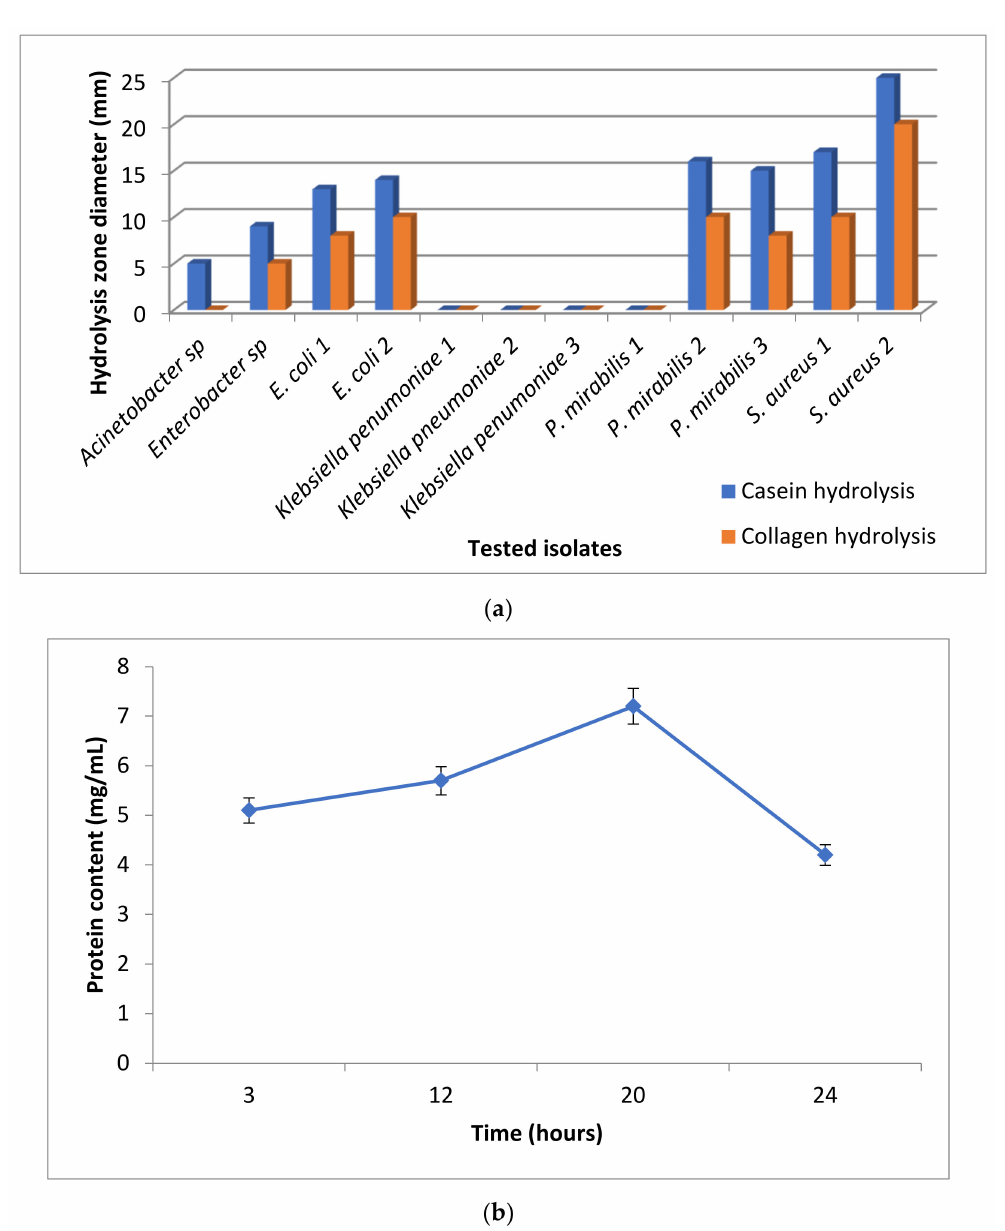
Figure 2. Enzyme activity using the hydrolysis zone method ( a ) and S. aureus strain 2 enzyme activity in azocasein substrate ( b